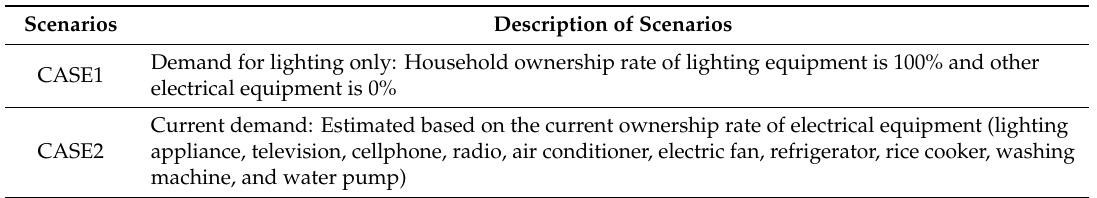
Table 6. Constructed scenarios for energy demand growth